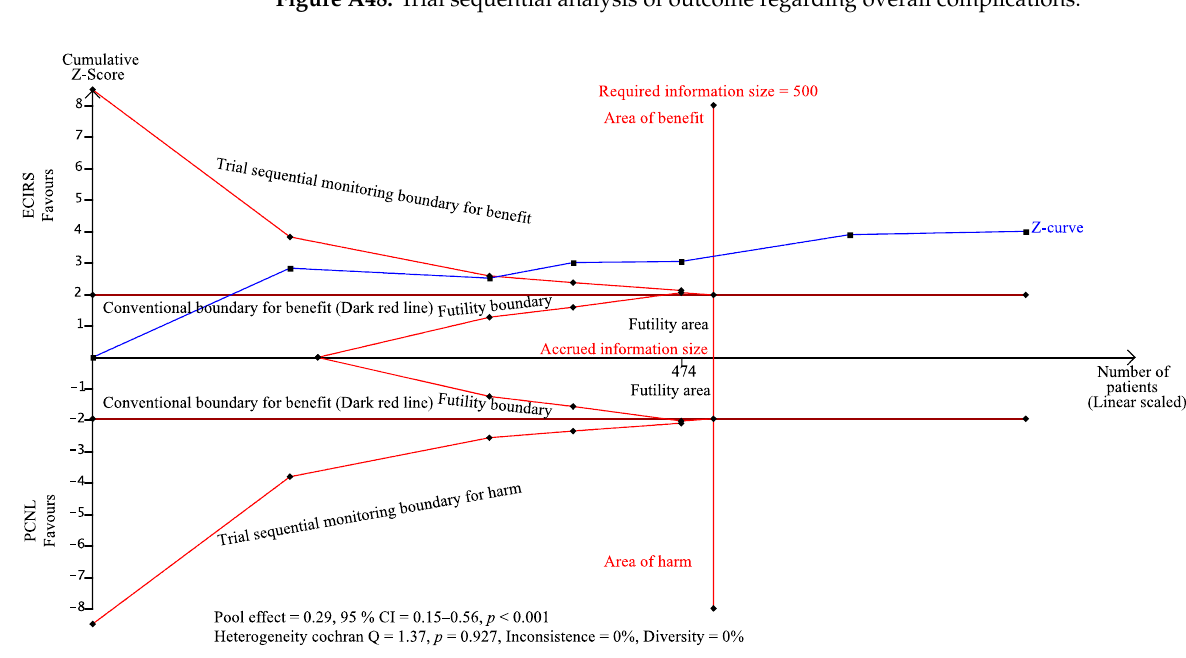
Figure A49. Trial sequential analysis of outcome regarding severe complications.